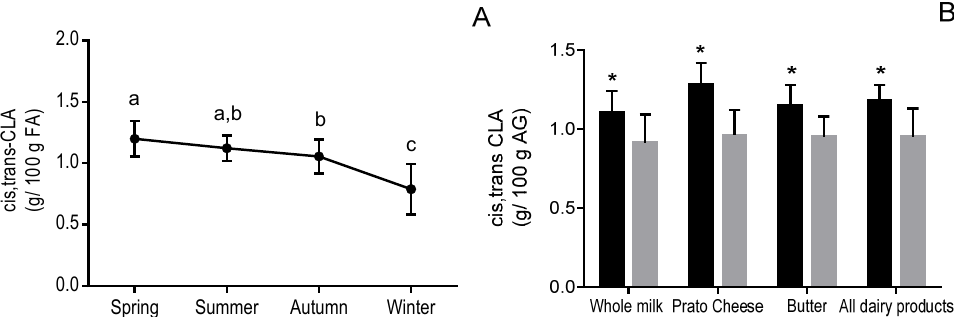
Figure 2. Seasonal variation ( A ) and effects of rainy and dry seasons ( B ) on the content of CLA in Brazilian dairy products. Data from all dairy products were combined. ( A ): Data points and error bars represent means and standard deviations, respectively. Means sharing a lowercase letter are not significantly different by ANOVA with Tukey’s post-test ( p < 0.05). ( B ): Spring and summer were the rainy seasons ( (cid:4) ) and autumn and winter were the dry seasons ( ). * Significantly different from the dry season by t test ( p < 0.05).